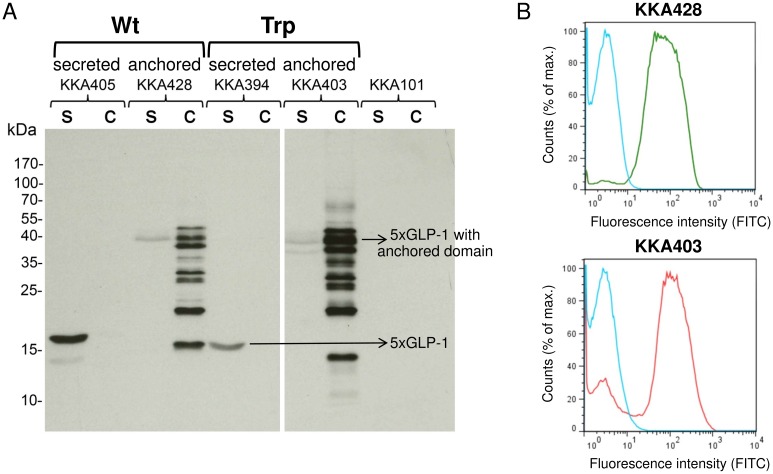
Expression and surface display of pentameric GLP-1 by transformed L. paracasei BL23.(A) Detection of 5×GLP-1 expressed by L. paracasei BL23 using Western blotting. Cell extract (c) and culture supernatant (s) of cell wall-anchored strain wt 5×GLP-1 (KKA428) and trp 5×GLP-1 (KKA403), as well as secreted strains, wt 5×GLP-1 (KKA405) and trp 5×GLP-1 (KKA394), are included. The predicted size of secreted 5×GLP-1 was 19.5 kDa (wt) and 19.4 kDa (trp) in the supernatant, whereas the anchored 5×GLP-1 fusion protein was 44.1 kDa (wt) and 44 kDa (trp) in the cell extract. (B) Surface display of anchored wt 5×GLP-1 (KKA428, green) and trp 5×GLP-1 (KKA403, red) produced by Lactobacillus in flow cytometry, as compared to the non-expressor strain (KKA101, blue).